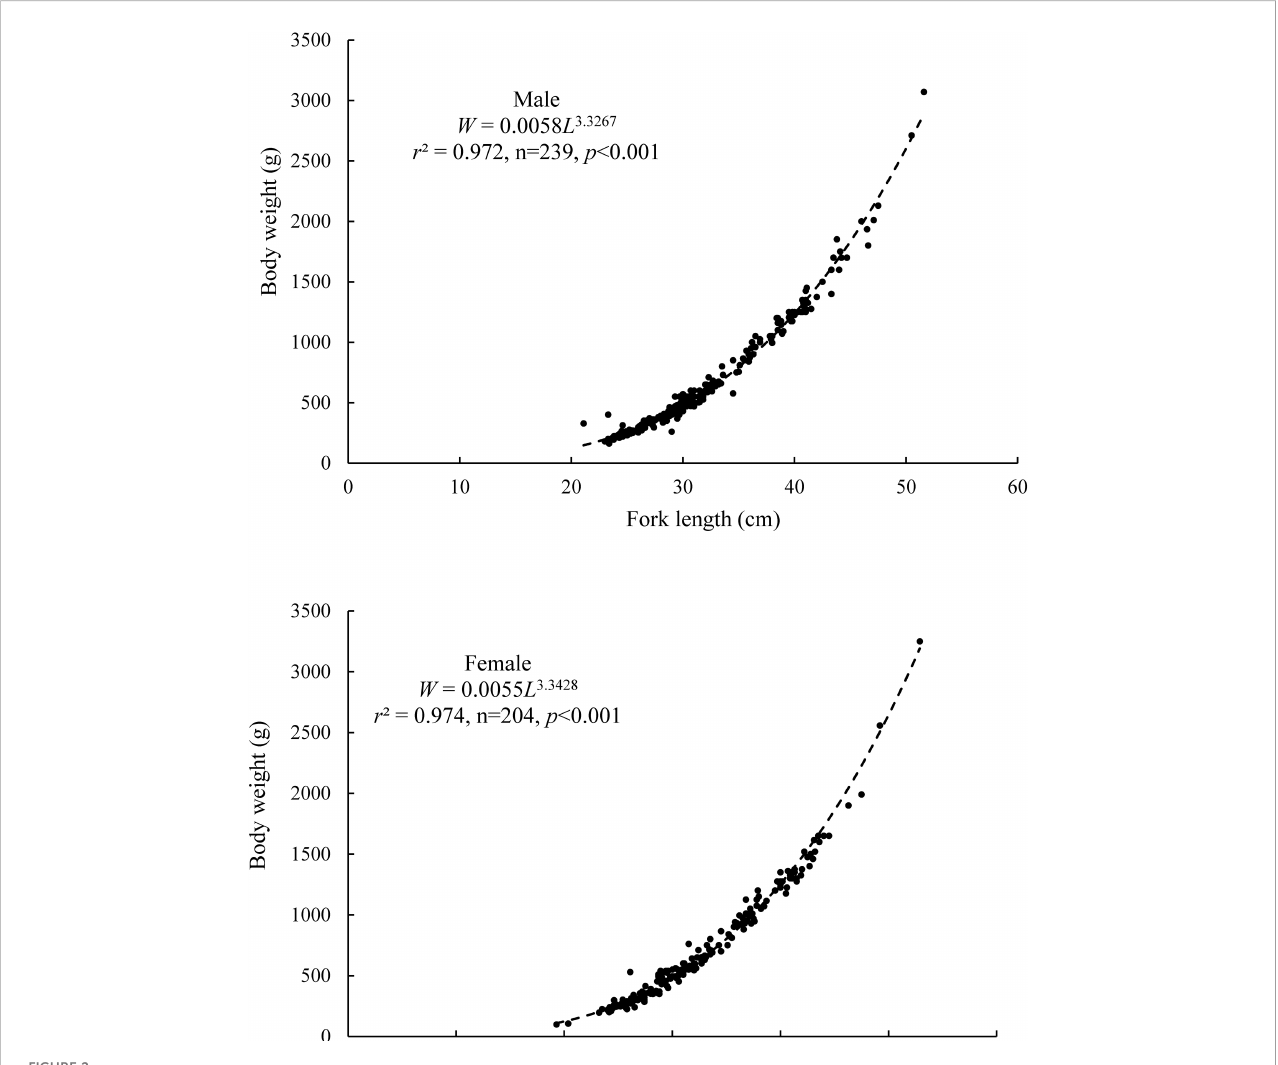
FIGURE 2 Male (upper) and female (lower) skipjack tuna length – weight relationships in the South China